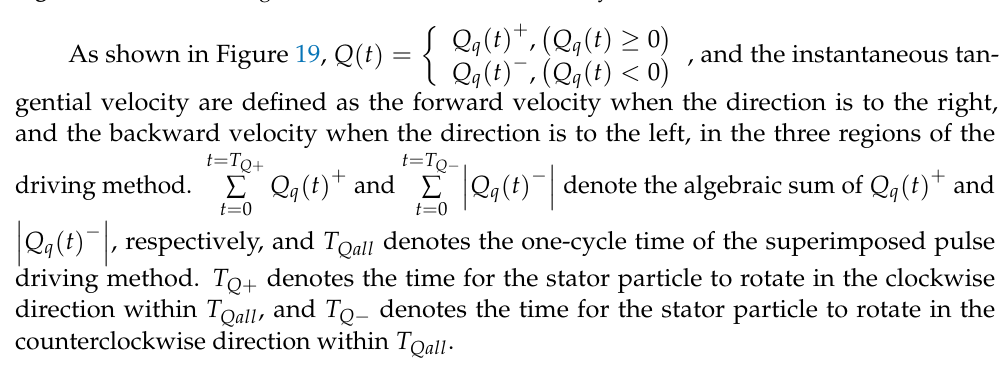
Figure 18. Schematic diagram for the instantaneous velocity of the rotor.